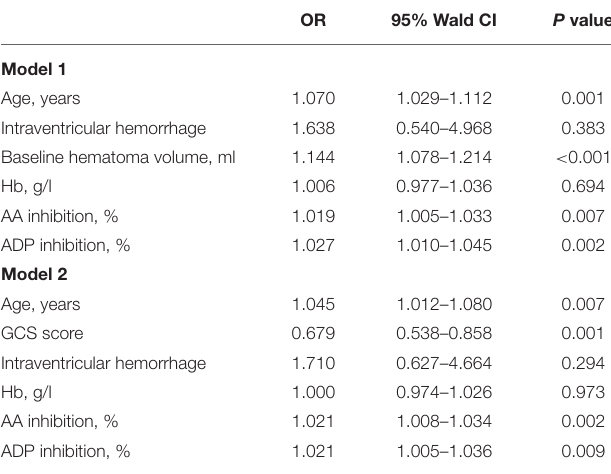
TABLE 4 | Multivariate analysis of predictors for poor outcome.